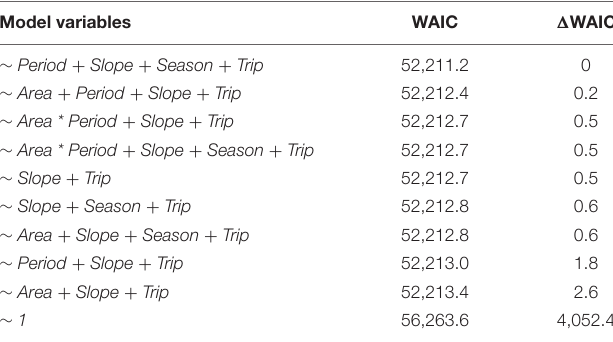
TABLE 1 | Candidate models examined for their fit to the data consisting of NASC , the amount of acoustic backscatter (i.e., fish biomass) in each 100 m grid cell in our sonar survey in marine protected area (MPA) and control areas and periods (Before and After closure). Model variables